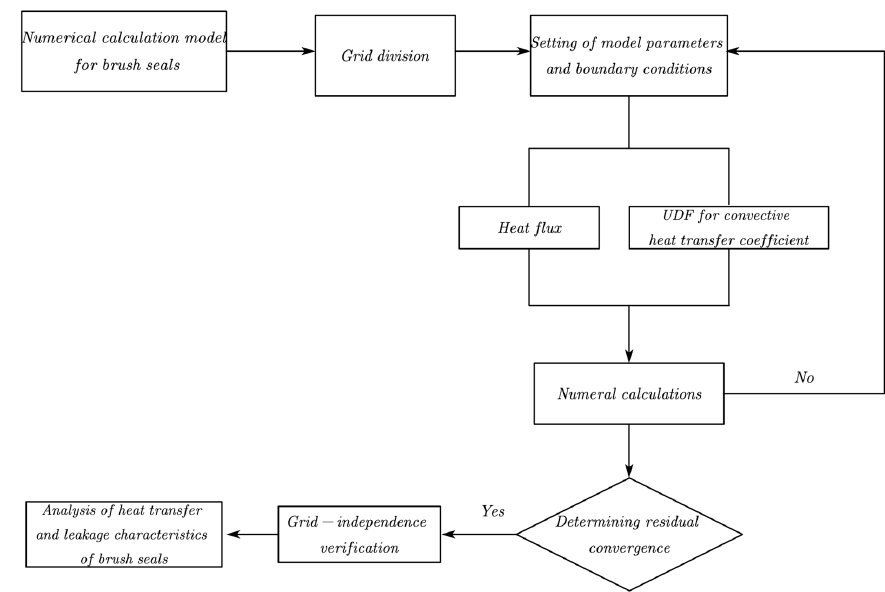
Figure 3. Flow chart of finite element analysis.